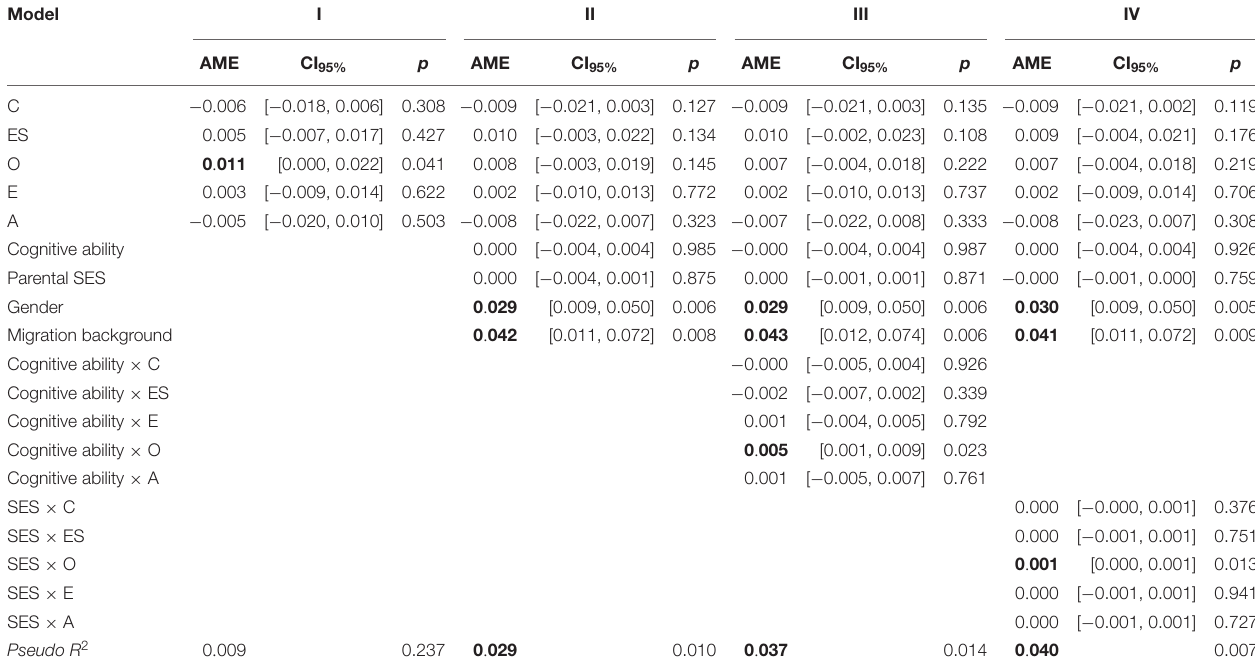
TABLE 6 | Average marginal effects for dropout intentions regressed on the Big Five and the covariates. Model